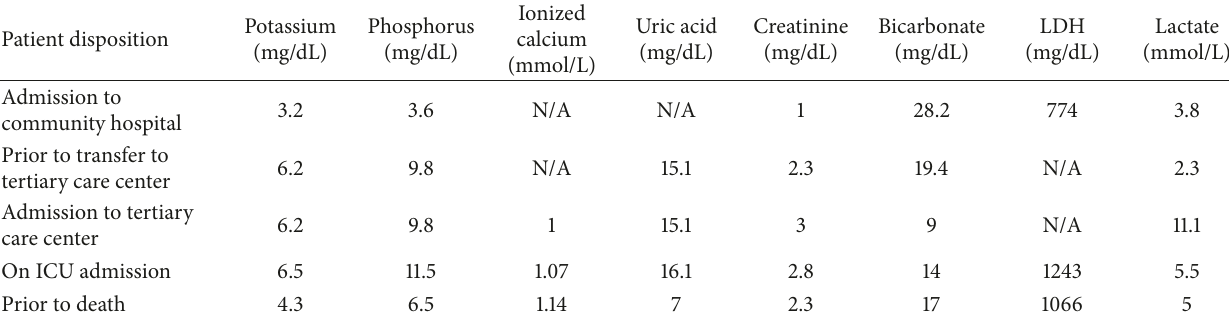
Table 1: Progression of the patient’s electrolyte derangements.